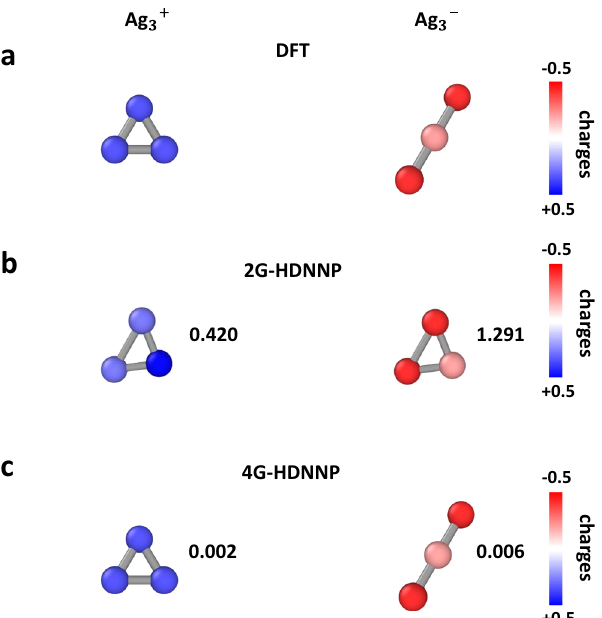
Fig. 5 Optimized geometry and atomic charges of Ag clusters. Structures and atomic partial charges of Ag þ and Ag (cid:2) optimized with DFT in a , the 3 3 2G-HDNNP in b and the 4G-HDNNP in c . The numbers give the root mean squared displacement (RMSD) in Å compared to the respective DFT minima. The partial charges in b are shown for illustration purposes only and have been obtained from a scaled 3G-HDNNP.